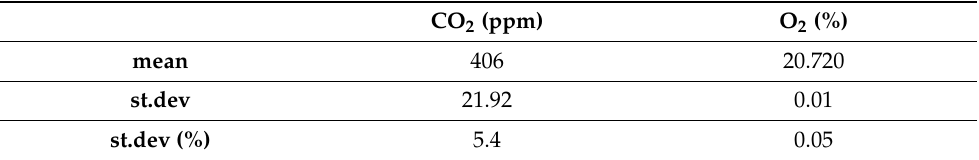
Table 3. Statistical data for noise of CO 2 and O 2 sensors. Historical data extended to last 1